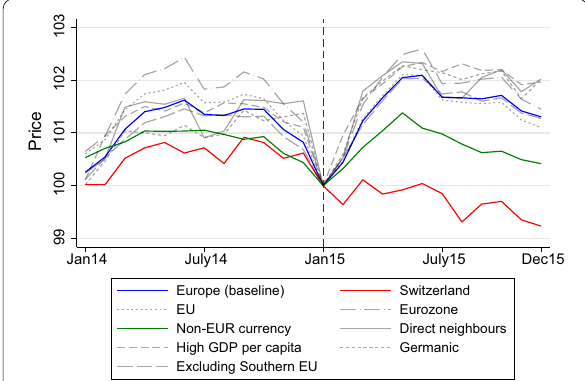
Fig. 2 Aggregate consumer prices for alternative control groups. Notes Monthly HICP all-items index with January 2015 prices normalized to 100. The components of the alternative control groups are defined in Table 1. Data source: Eurostat (2022)